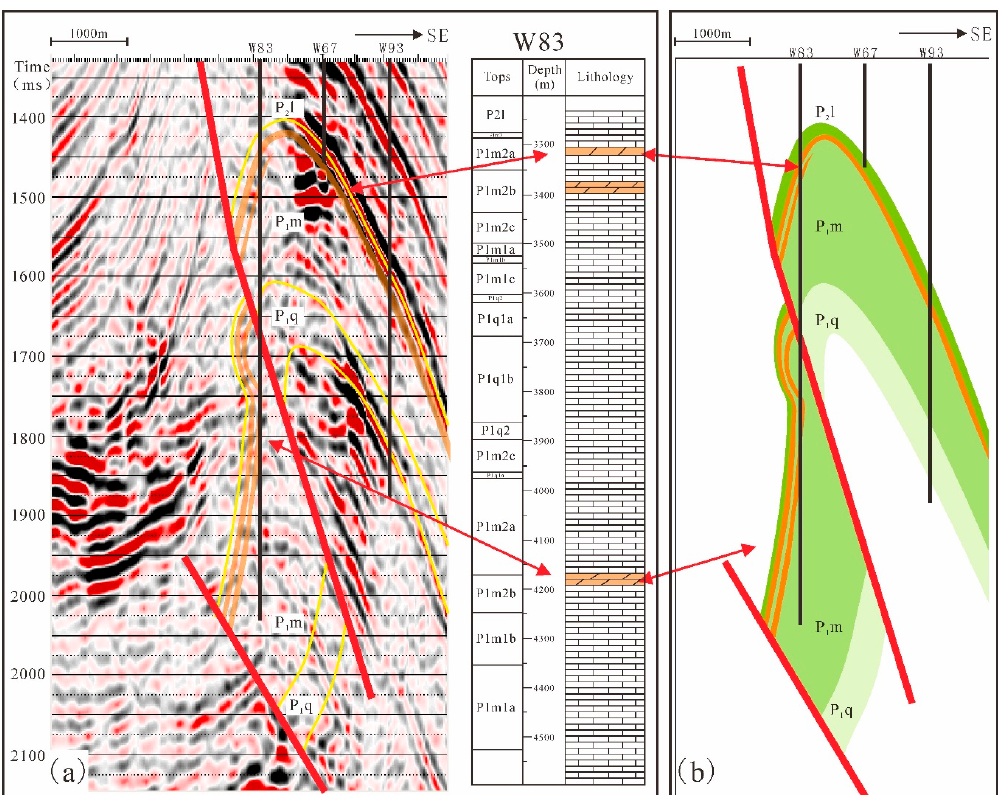
Figure 12. Tectonic reflection burial depth map of Maokou Formation in the study area.